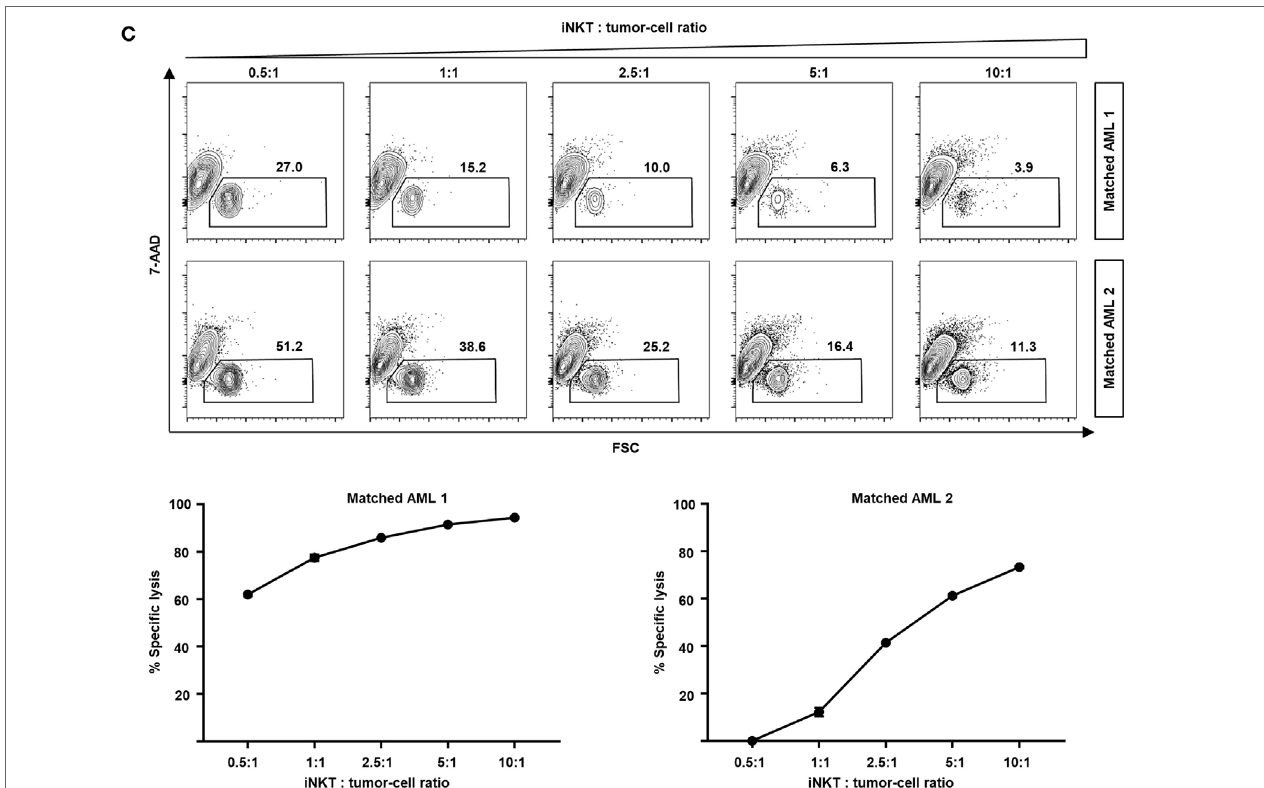
FigUre 4 | Dose-dependent kill of leukemia cell lines and patient leukemia cells by culture-expanded human invariant natural killer T (iNKT) cells. (a) Representative dot plots and specific lysis of MOLT-4 (92% 7-AAD- without iNKT cells) and Jurkat leukemia cells (87% 7-AAD- without iNKT cells) after co-incubation with culture-expanded iNKT cells. Each graph shows pooled data from four independent experiments with different culture-expanded iNKT cells. (B) Representative dot plots and specific lysis of AML M1 (88% 7-AAD- without iNKT cells) and AML M5 patient leukemia cells (89% 7-AAD- without iNKT cells) after co-incubation with culture-expanded HLA-mismatched iNKT cells. Each graph shows pooled data from four independent experiments with different culture-expanded iNKT cells tested against different patient AML cells. (c) Representative dot plots and specific lysis of patient leukemia cells (74 and 51% 7-AAD- without iNKT cells, respectively) after co-incubation with culture-expanded HLA-matched donor iNKT cells. Shown are two representative examples from three independent experiments. All events are gated on PBS57-loaded CD1d tetramer phycoerythrin negative cells to exclude iNKT cells. Error bars indicate